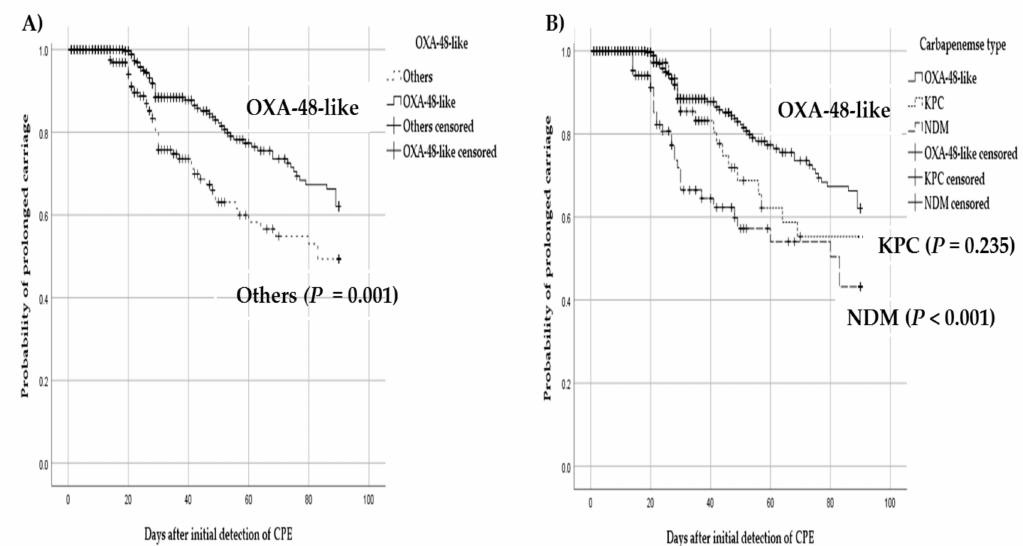
Figure 1. Kaplan–Meier estimates for the cumulative probability of prolonged carriage according to the types of carbapene- mase. ( A ) OXA-48-like versus other types of carbapenemase gene (log-rank test); ( B ) stratified by three different types of carbapenemase gene (log-rank test). Abbreviations: OXA-48-like, Oxacillinase (OXA)-48-like; NDM, New-Delhi-Metallo- beta-lactamase; KPC, Klebsiella pneumoniae carbapenemase; CPE, carbapenemase-producing Enterobacteriaceae